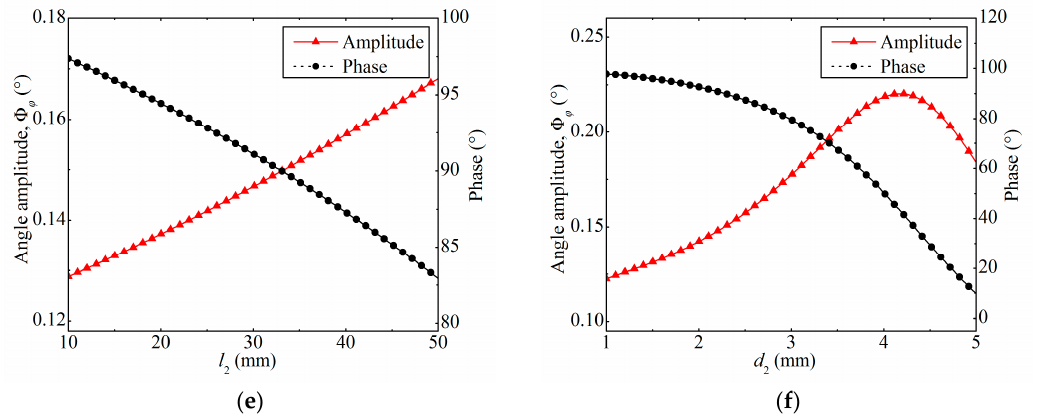
Figure 8. The influence of the pipes. ( a ) Length of the load pipe ( l 4 ); ( b ) diameter of the load pipe ( d 4 ); ( c ) length of the pipe before the control valve ( l 1 ); ( d ) diameter of the pipe before the control valve ( d 1 ); ( e ) length of the pipe behind the control valve ( l 2 ); and ( f ) diameter of the pipe behind the control valve ( d 2 ).